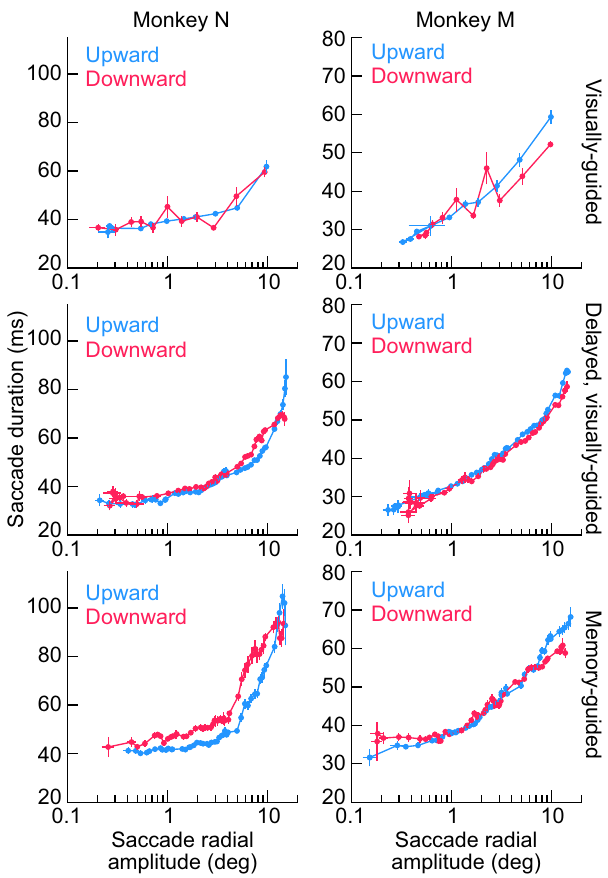
Fig. 5 Saccade durations as a function of saccade amplitude are also largely insensitive to whether saccades are directed towards the upper or lower visual fi eld. Same as Fig. 4 but now plotting saccade duration as a function of saccade amplitude. Similar conclusions were reached concerning the minimal in fl uence of upper versus lower visual fi eld saccade target locations on saccade kinematics, despite asymmetries in SC motor bursts (Fig. 1). For monkey N in the memory-guided condition (left panel of the bottom row), the slower lower visual fi eld saccade peak speeds (Fig. 4) meant slightly longer saccade durations when compared to upper visual fi eld saccades (a speed-duration tradeoff). Error bars denote